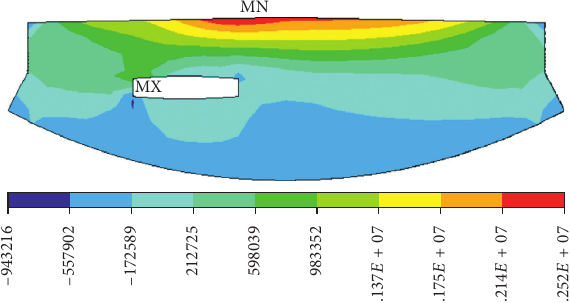
Figure 14: First principal stress of tunnel substructure (Pa) before the treatment.